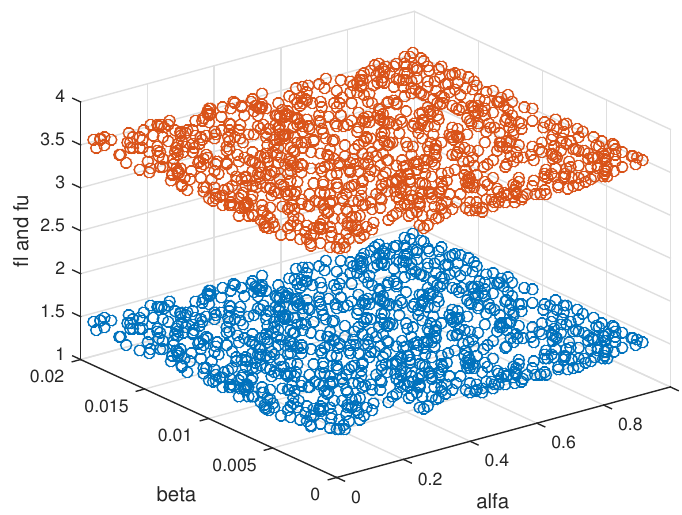
Figure 3. Efficient space for Example 3 with SOC constraint using n = 1000.